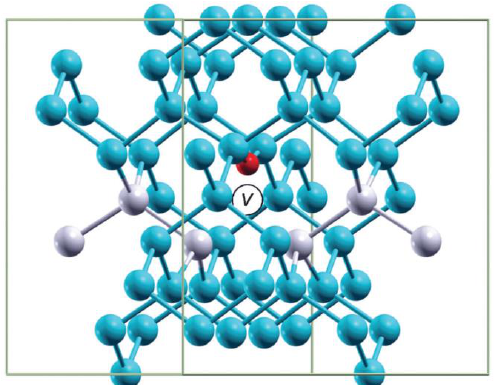
Figure 7. The A-center. The red sphere is the O atom and the white circle the vacancy. Reproduced by permission from the PCCP Owner Societies 2014 [113].